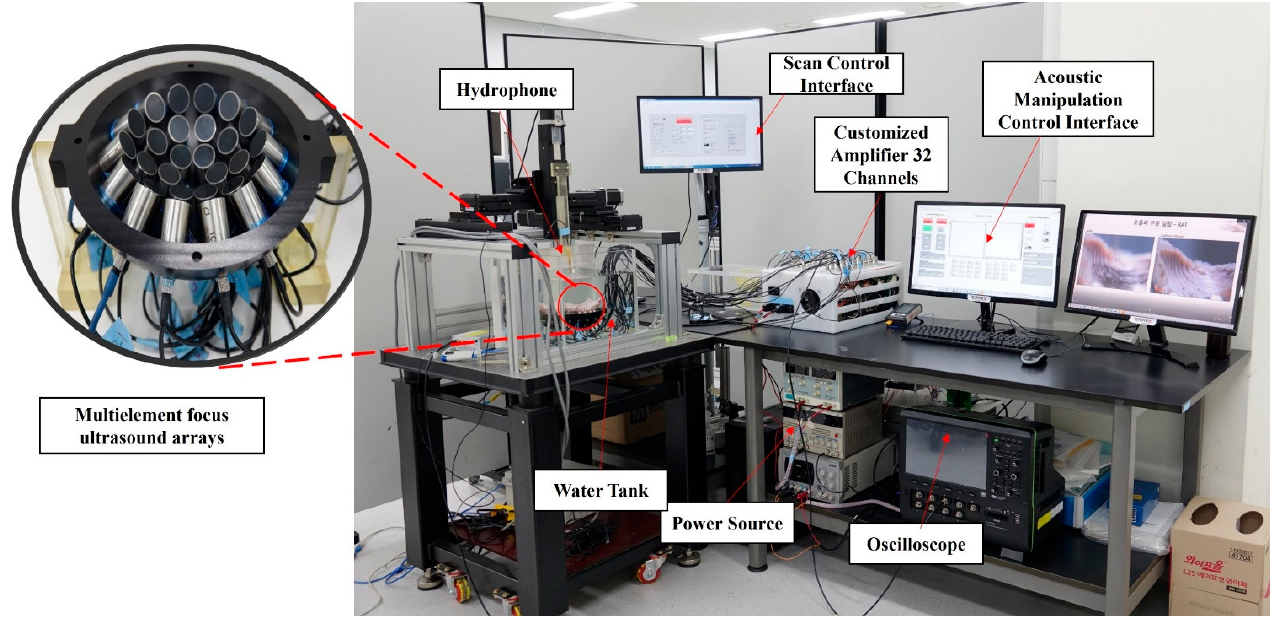
Figure 8. Experimental setup of the acoustic manipulation system for five-DoF manipulation control: List of all components in the AcoMan system ( right ) and fabricated multi-element focus ultrasound arrays ( left ).